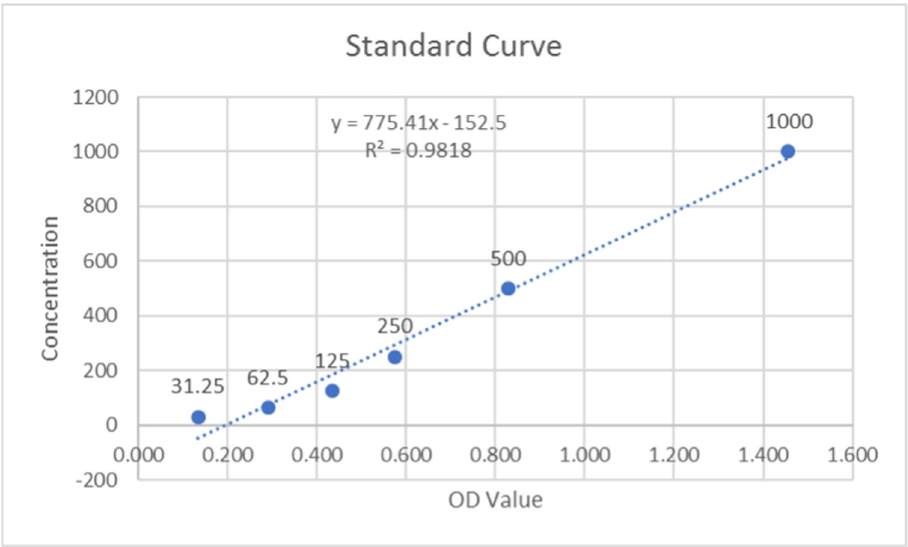
Molecules 2022 , 27 , x FOR PEER REVIEW Figure 1. Standard curve of MMP-9 for control group. Figure 1. Standard curve of MMP-9 for control group.